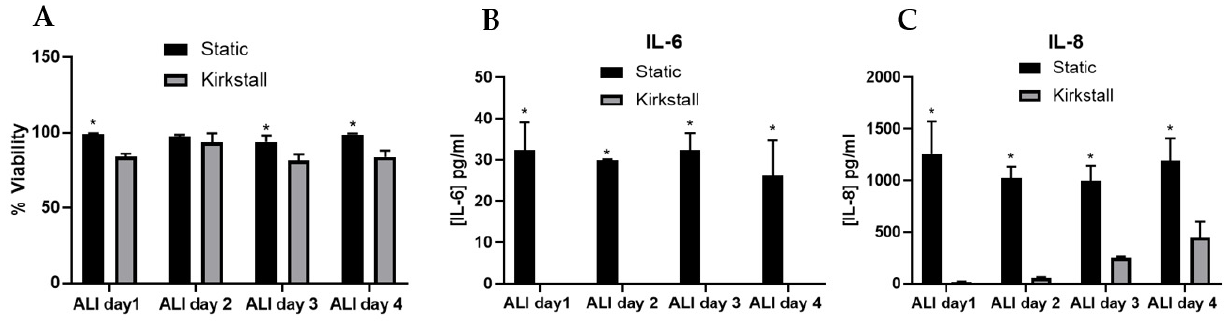
Figure 2. Characterisation of A549 + dTHP-1 co-cultures in both static (black bar) and under fluid flow conditions (grey bar). Cells were analysed at ALI days 1, 2, 3 and 4, focusing on cytotoxicity ( A ), IL-6 ( B ) and IL-8 ( C ) concentration. N = 3 with all assays performed in triplicate. The data is presented as the mean ± standard deviation. Significance is denoted as the following: compared to the fluid-flow equivalent p < 0.01 (*).